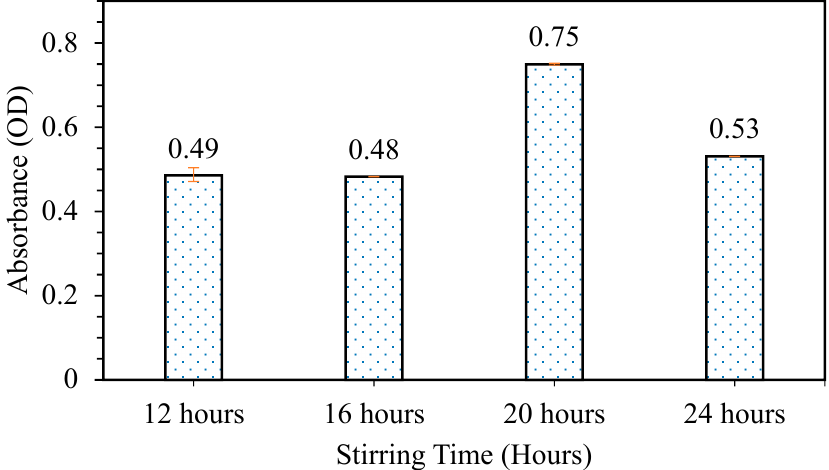
Figure 6. Releasing test of patches prepared at different stirring times (phycocyanin/alginate ratio at 40/60).